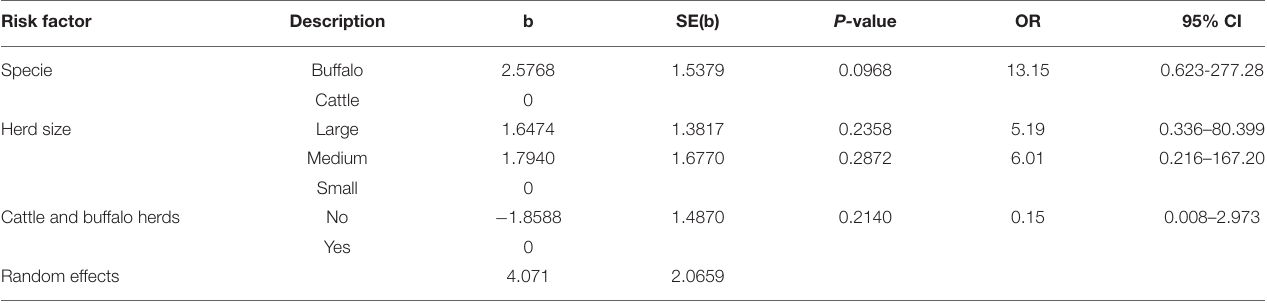
TABLE 3 | Generalized Linear Mixed Model with random effects of farm and individual-animal-level risk factors associated with the infection by M. bovis in 832 animals (106 cattle and 45 buffalo) in 41 farms in Amazonas State.